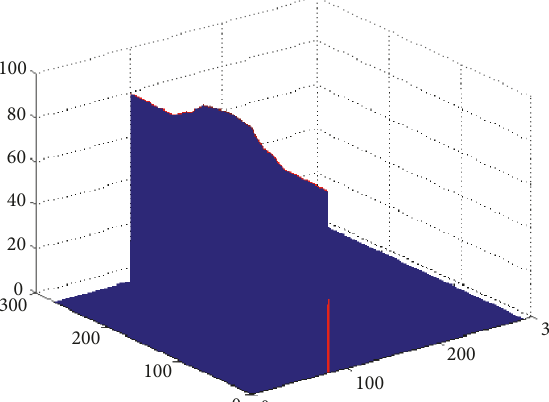
Figure 5: The effect after expansion.